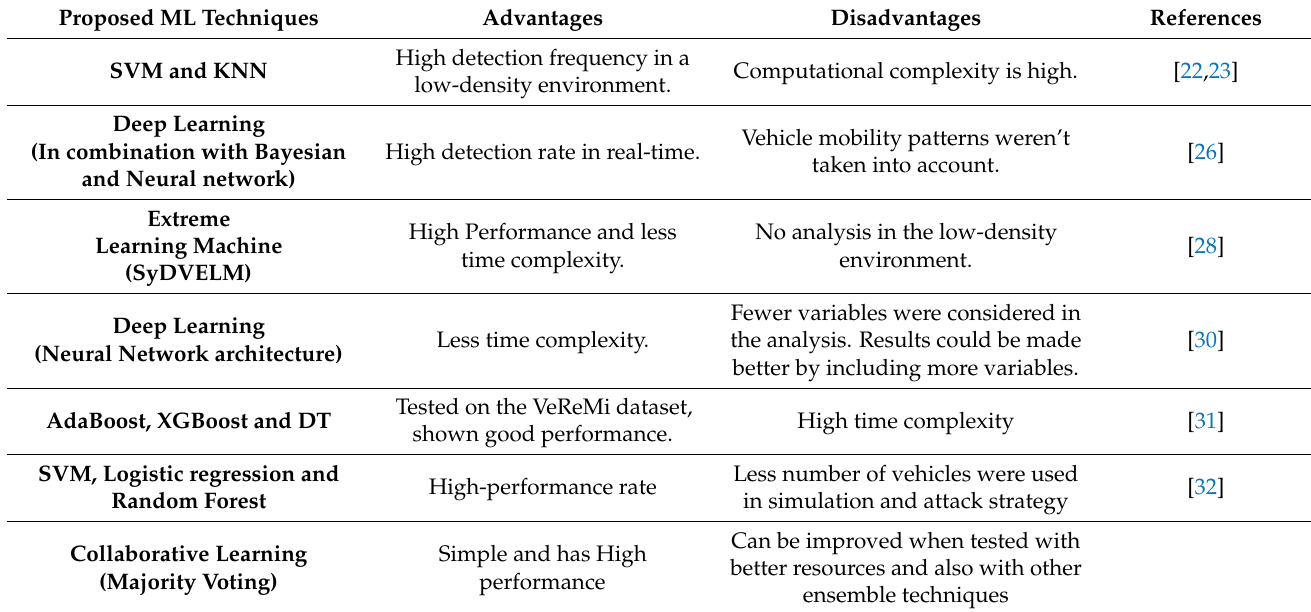
Table 1. Summary of previous Machine Learning work and proposed technique for Sybil attack detection. Proposed ML Techniques